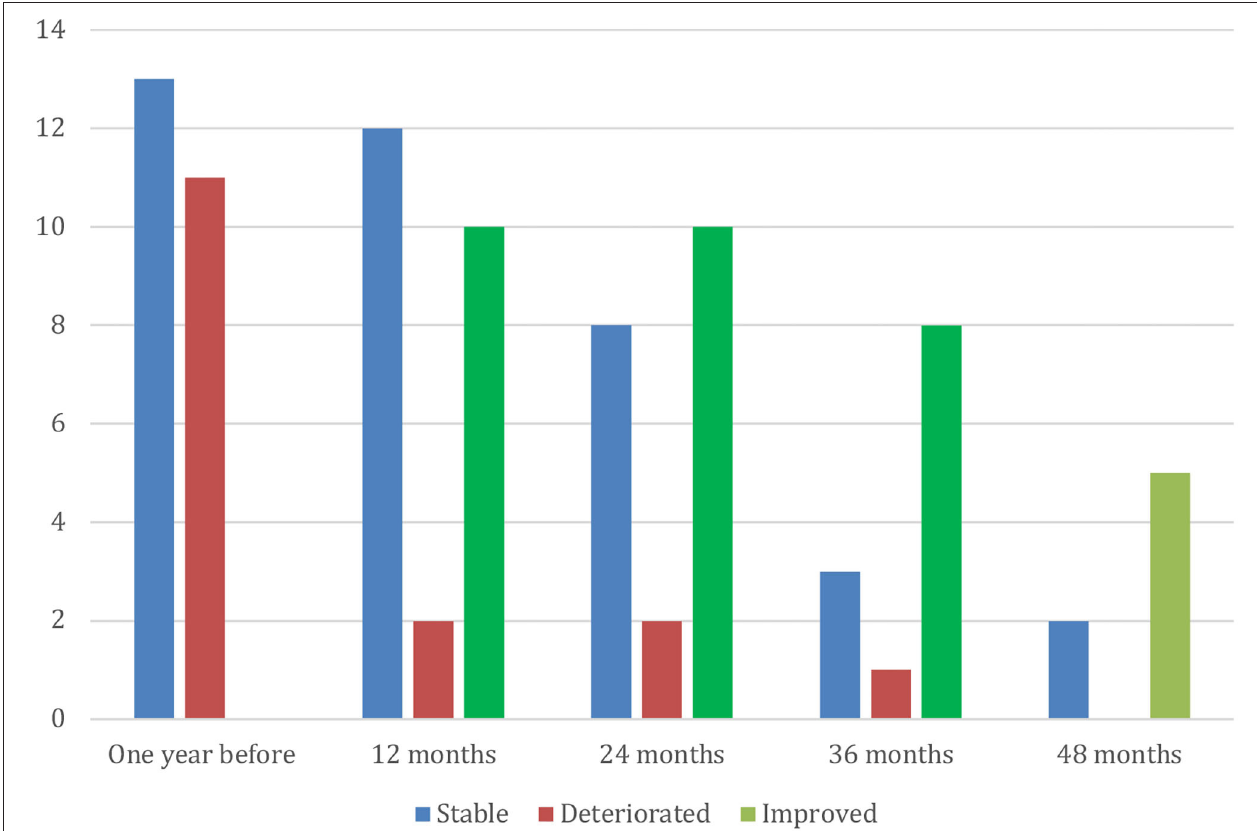
FIGURE 3 | Number of patients with improvement or deterioration in EDSS compared with baseline.